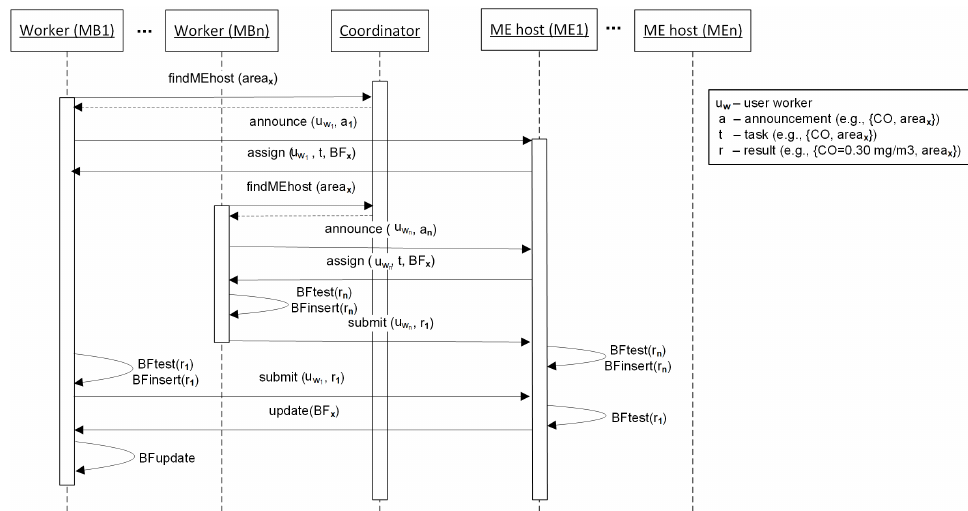
Figure 3. An algorithm for autonomous decision-making of a moving worker regarding its participa- tion in the data acquisition